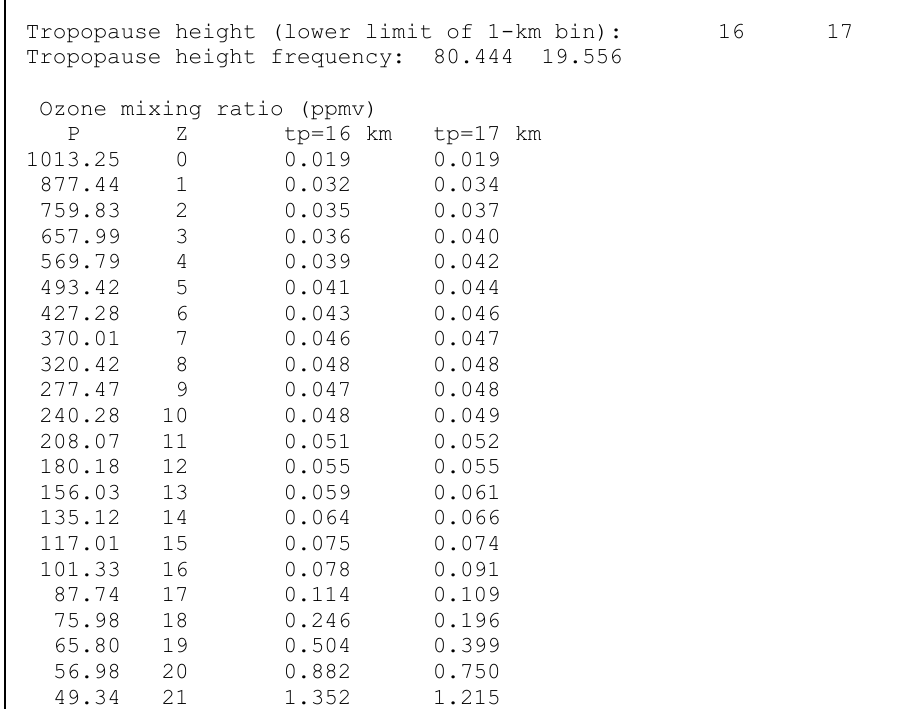
Fig. 15. An example of the records in the ASCII file for single-tropopause cases. The occurrence frequency (the probability distribution) of tropopause heights is presented in %. After the ozone mixing ratio, values of the standard deviation are written in the file.